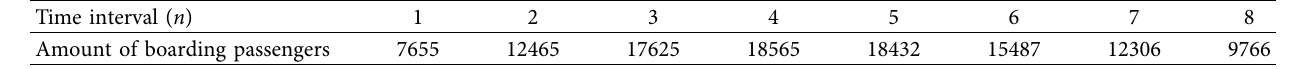
Table 8: Number of boarding passengers in each time interval with control.